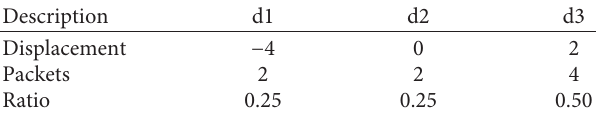
Table 2: Reorder Density (RD) for the eight-packet